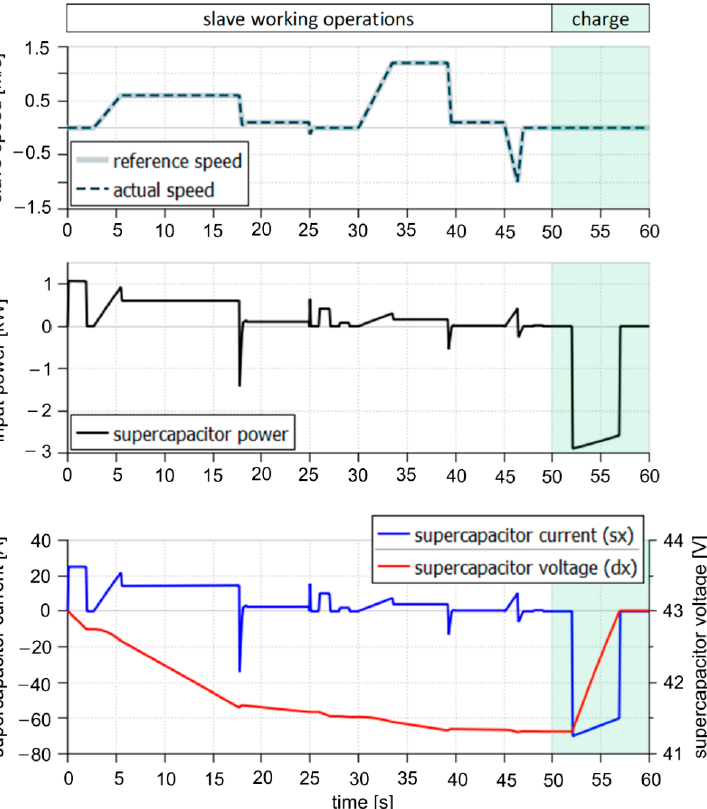
Figure 2. Working profile for the slave shuttle in the original configuration with the supercapacitor. Speed ( top ), electric drive input power ( middle ), storage voltage and current ( bottom ) (courtesy of [3]).